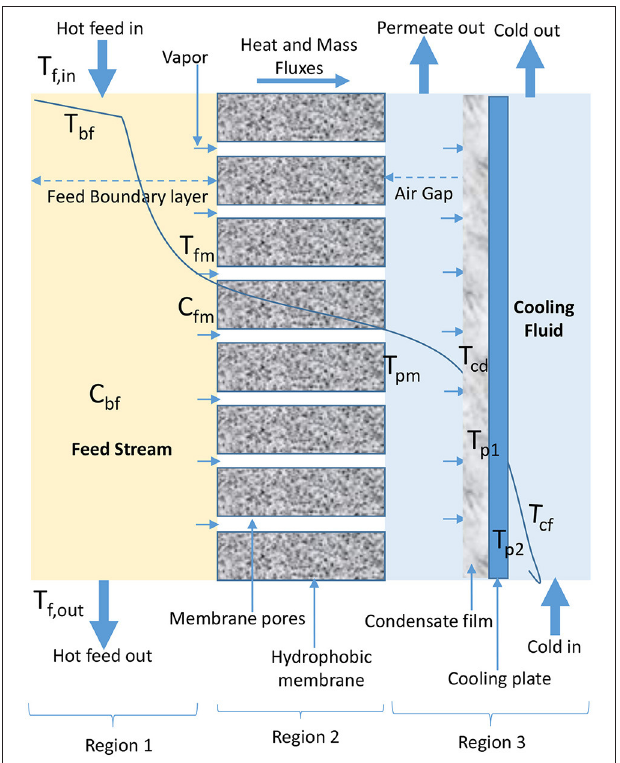
FIGURE 3 | Heat and mass transfer in AGMD configuration (adapted from Khayet and Matsuura, 2011c).